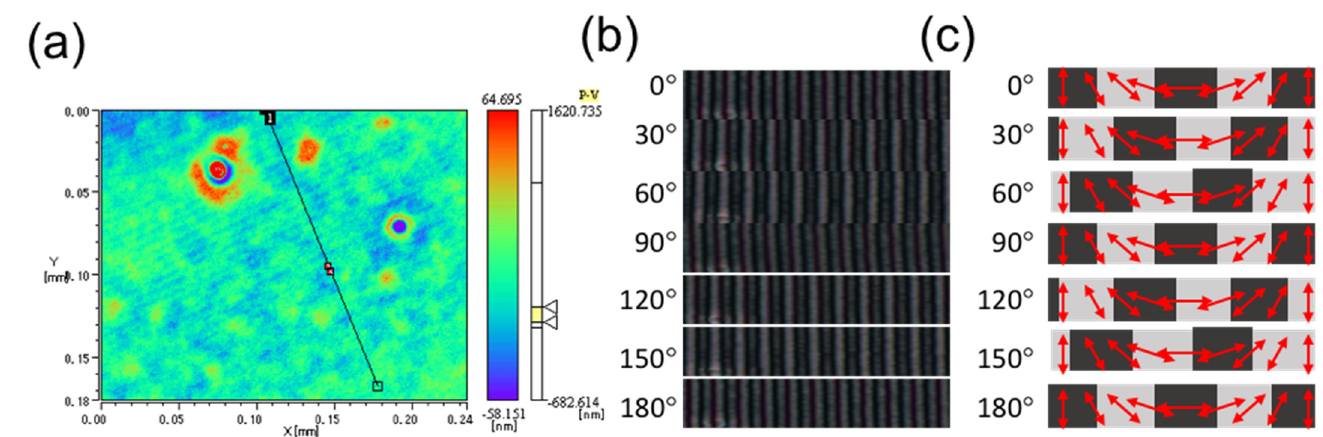
Figure 4. ( a ) Surface profile of P1 after irradiation with interference beams following thermal annealing (5 s, 240 ◦ C). ( b ) Polarizing micrographs observed as a function of the rotation angle of the polarizer and analyzer, θ . ( c ) Alignment of mesogens induced in holograms. The arrows indicate the direction of mesogens. The white and gray areas correspond to the bright and dark areas, respectively, in ( c ).